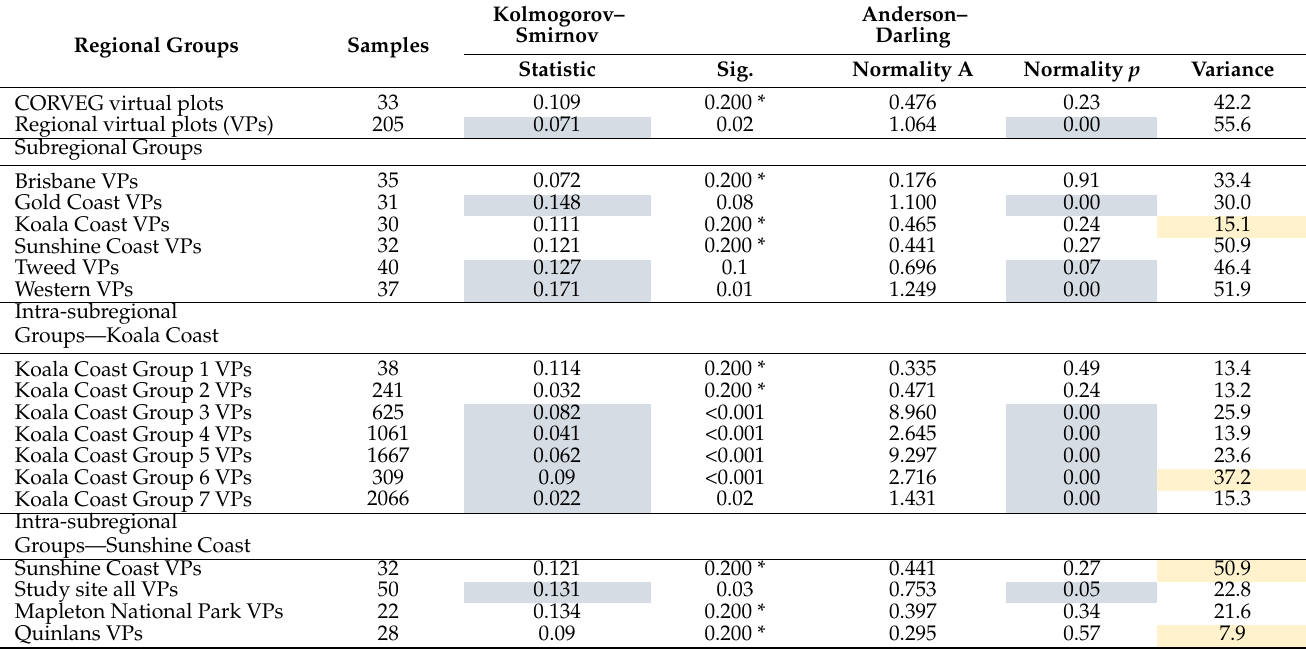
Table 3. Virtual ALS plot datasets are characterised by uneven sample sizes, non-normal data distribution, and unequal variances. We used both the Kolmogorov–Smirnov (with Lilliefors Significance Correction) and Anderson–Darling normality tests. Non-normal datasets are shown in blue, and highly unequal variances are shown in orange. * denotes maximum significance level reported by software